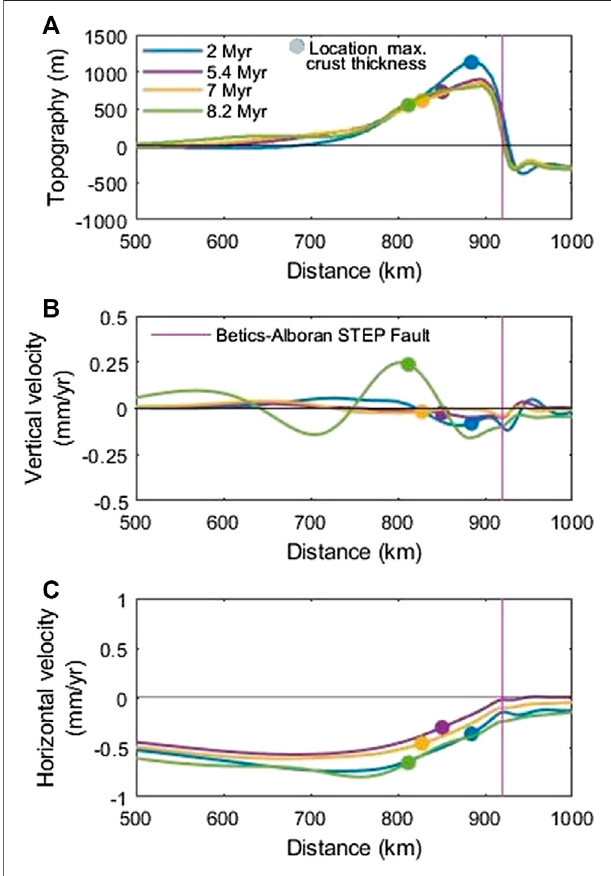
FIGURE 11 | (A) Topography, (B) vertical velocity, and (C) horizontal velocity of the free surface at different time steps of the Slow Model. The location of the maximum crustal thickness at each time step is also marked (colored dots) to facilitate the interpretation.